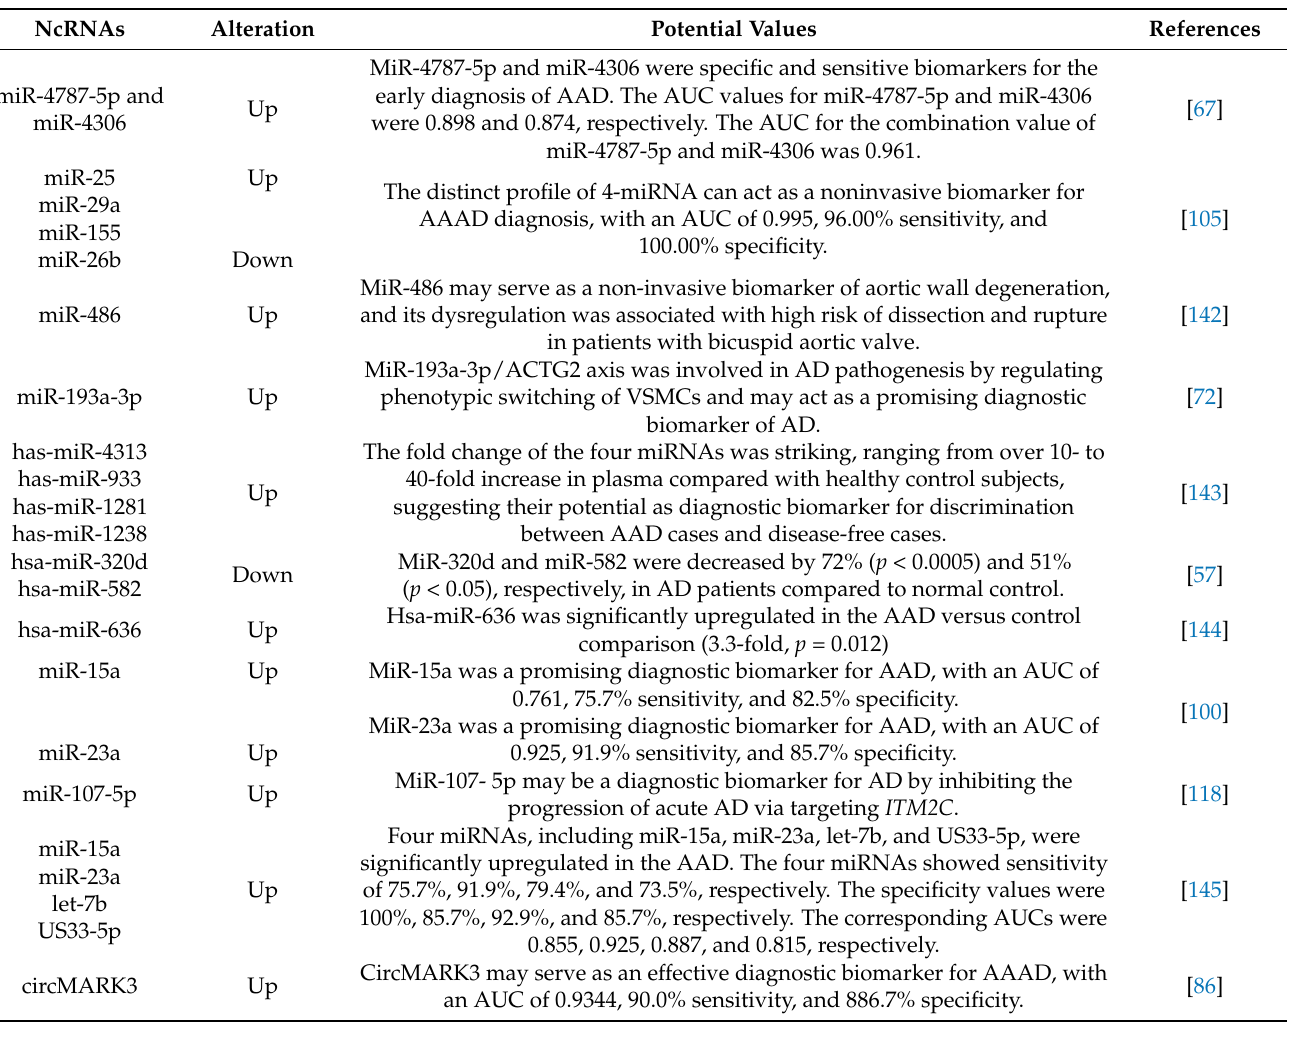
Table 2. NcRNAs as diagnostic biomarkers in